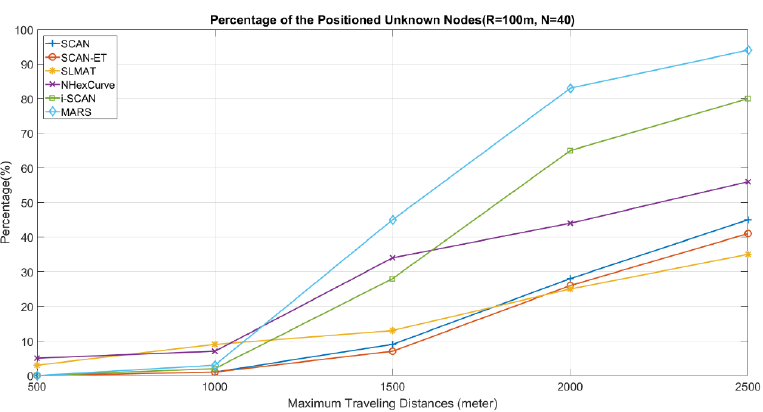
Figure 7. The percentage of positioned unknown nodes with limited traveling distance.